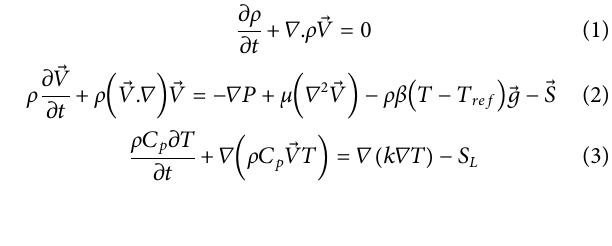
Frontiers in Energy Research |